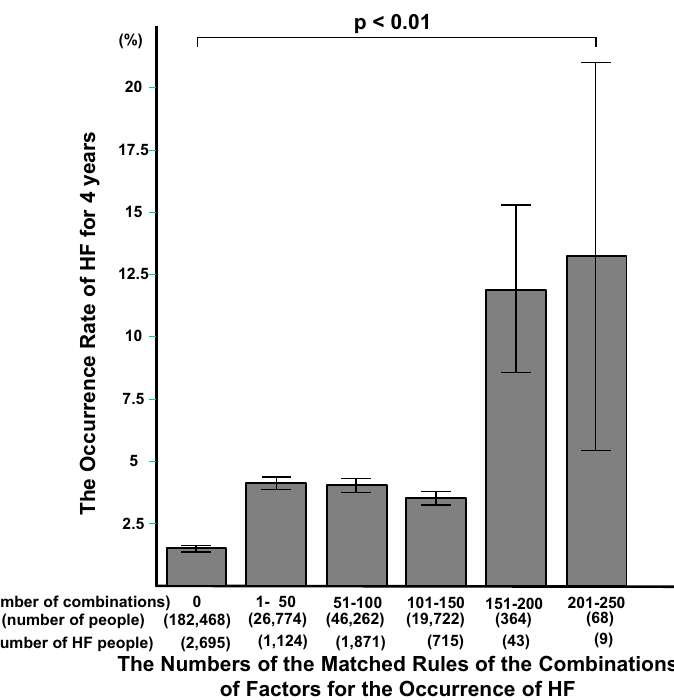
Figure 1. The relationship between the number of combinations of factors obtained in one cohort and the probability of HF occurrence in another cohort. As the number of the combinations of factors applied to each person increases, the probability of the incidence of HF